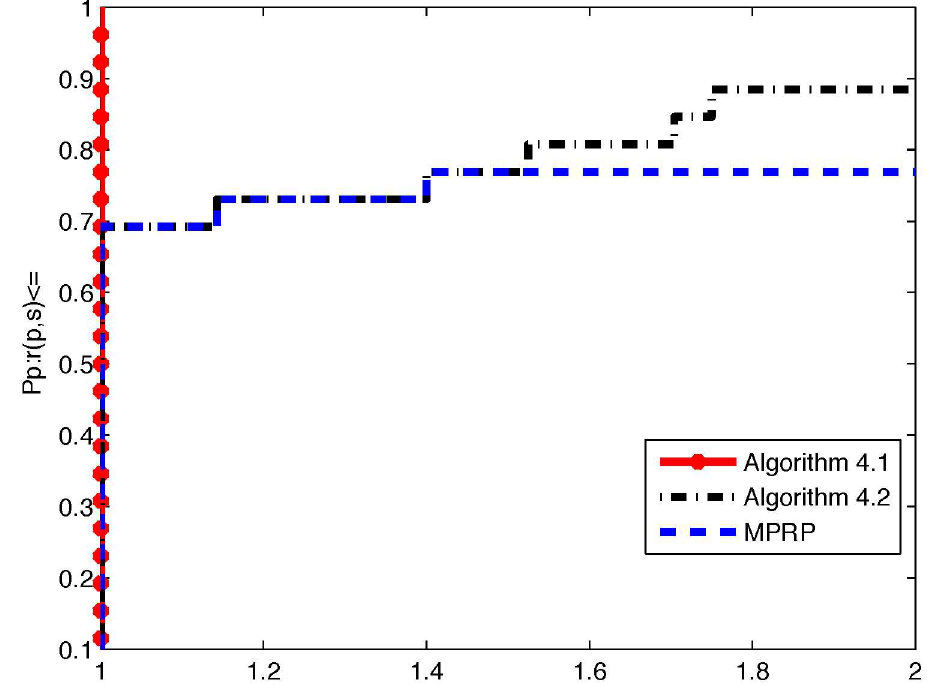
Fig 1. Performance profiles of these methods (NI).